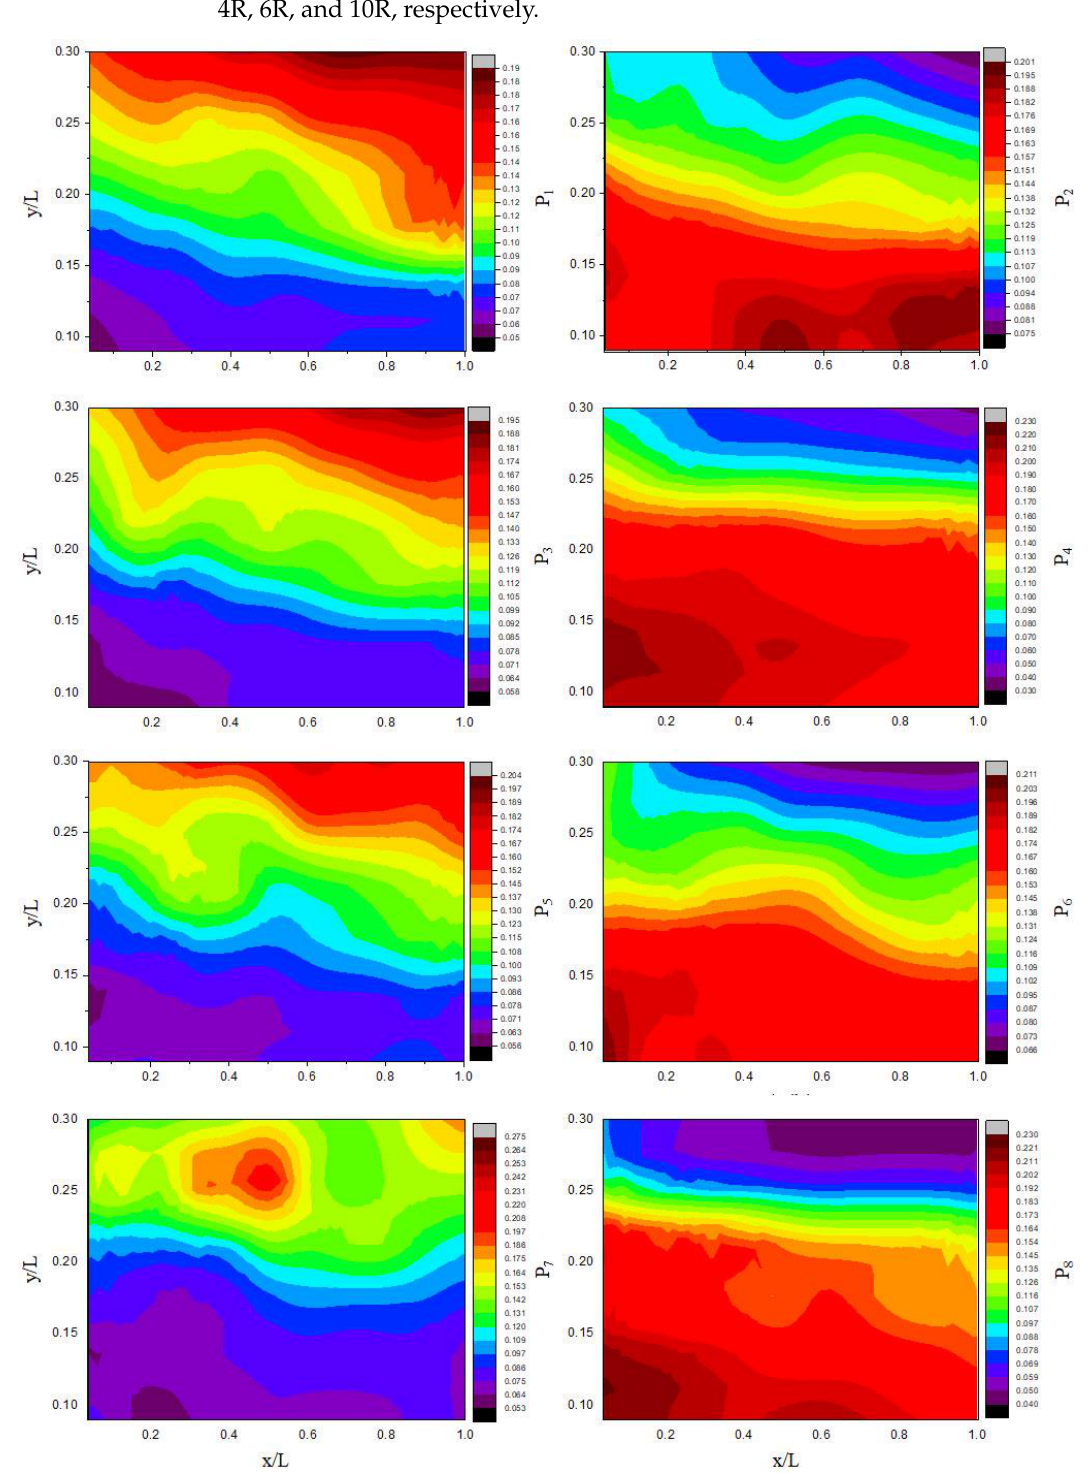
Figure 8. Contours maps of depth-averaged occurrence probability of octagonal bursting events (P 1 –P 8 ) for the experimental run 2R.